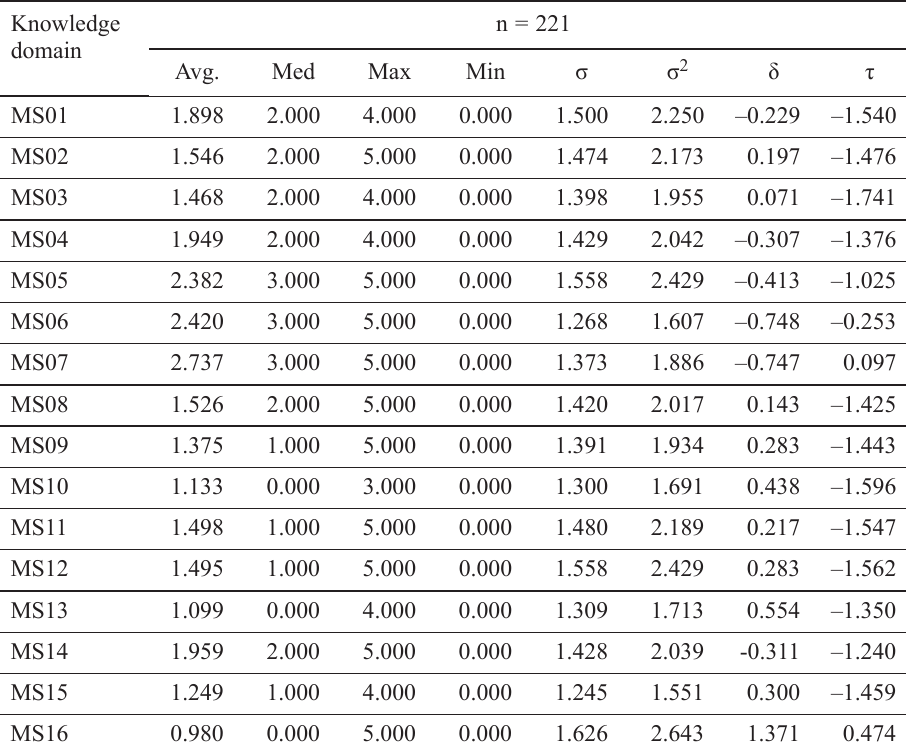
Table 9. Statistical survey amongst schools in